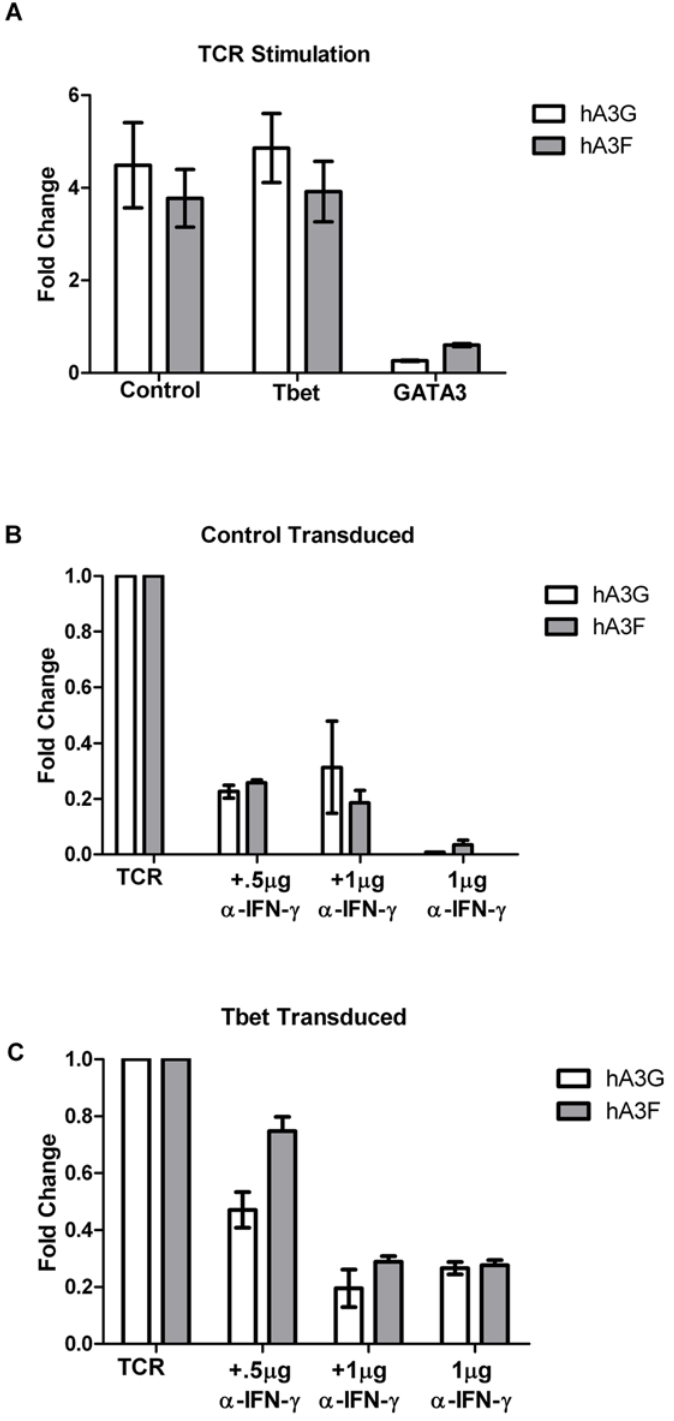
Figure 3. Interferon gamma regulates expression of hA3G and hA3F in Tbet but not GATA3 transduced cells. Control, Tbet, and GATA3 transduced cells were TCR stimulated with CD3/CD28 beads. Cytoplasmic RNA was then isolated to determine the fold change in mRNA expression by qRT-PCR (A). Control (B) and Tbet (C) transduced cells were TCR stimulated or left unstimulated in the presence of a neutralizing anti-interferon gamma antibody. The fold change in mRNA expression was again determined by qRT-PCR. Incubation of TCR stimulated cells with isotype control does not differ significantly from stimulation alone (data not shown). Error bars represent standard deviation from the mean.